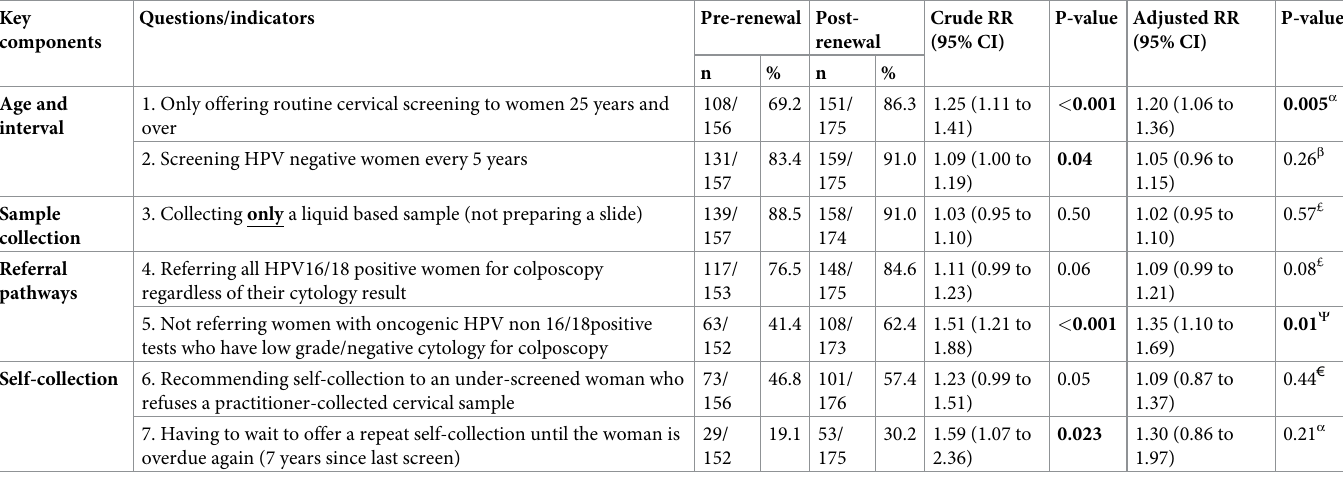
Table 3. Practitioners’ comfort in implementing the renewed program in the pre- and post-renewal samples � . Key